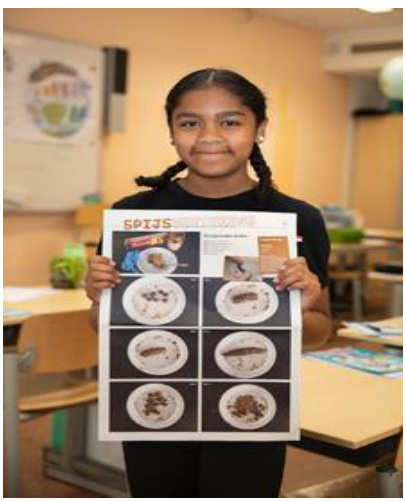
Figure 6. Making poop out of peanut butter and ginger bread.